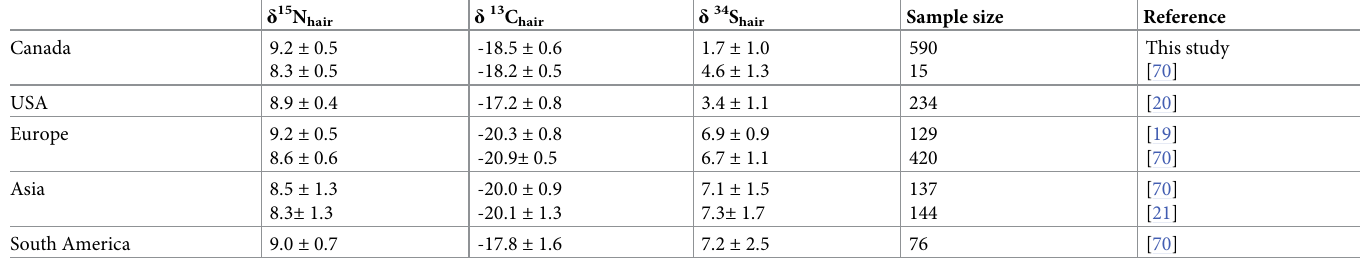
Table 2. Comparison of δ 15 N hair , δ 13 C hair and δ 34 S hair values between administrative regions or countries. Data of δ 15 N hair and δ 13 C hair values exist for other countries but do not include δ 34 S hair values or only include a few individuals (for a summary or country level details about those isotopic data see [25] and [70]).